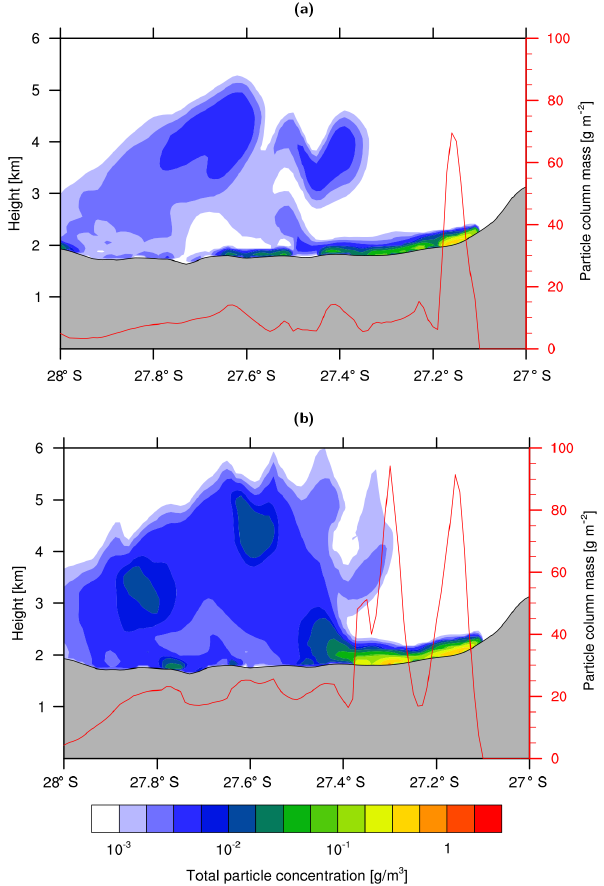
Figure 12. Spatial distribution of the modeled dust concentration over the Fiambalá Basin. Meridional cross section along longitude 67.7 ◦ W. The red solid line represents the particle column mass pro- file. The emission sources are centered around the peaks of column mass. (a) 13 June at 11:00UTC. (b) 13 June at 16:00UTC.